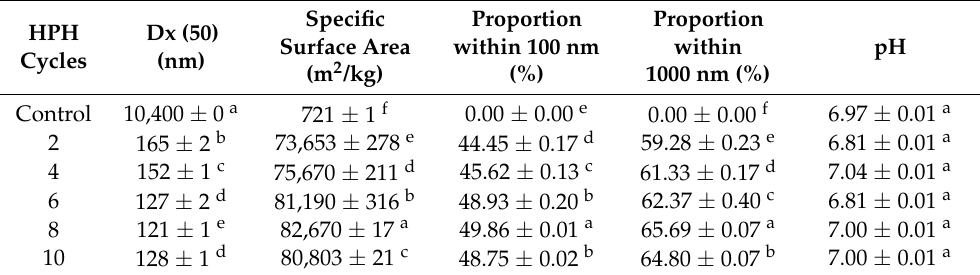
Figure 3. Effects of HPH on the particle size distribution ( A ) and microstructure ( B ) of RBAS. ( C ) Photo of RBAS treated with different HPH cycles after standing at 4 °C for 24 h. ( D ) Stability (standing at 4 °C for 24 h) and zeta potential of RBAS. In figure, different lowercases in each group showed significant differences ( p < 0.05). Table 2. Particle size characteristics and pH of rabbit bone aqueous suspensions